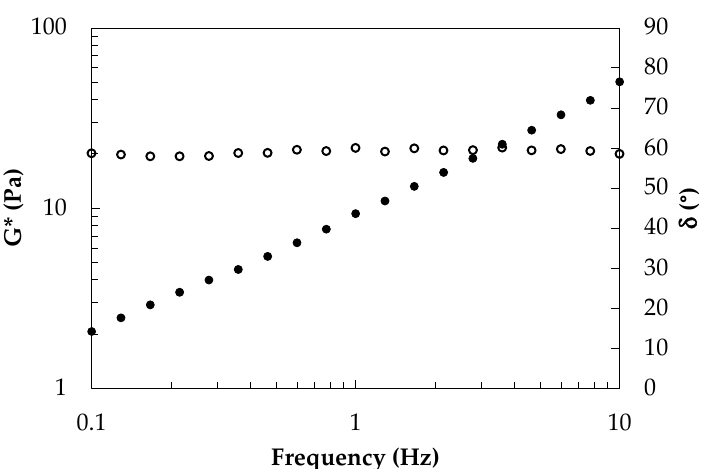
Figure 1. Complex modulus (full symbols) and phase angle (open symbols) of oil phase at 25 °C as frequency function.